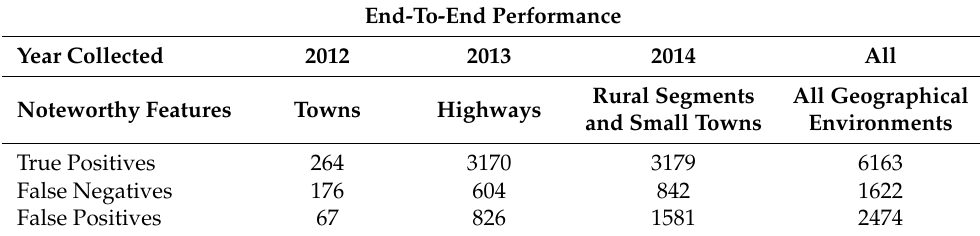
Table 4. A performance benchmark of the full system end-to-end. Raw images are fed into GPS- RetinaNet, which detects signs, predicts their class, and regresses their GPS offsets. Pairs of detections from consecutive frames predicted by GPS-RetinaNet are fed into the similarity network to predict a similarity score. These similarity scores are provided to the Hungarian algorithm to merge repeated detections of the same sign. These final sign predictions are compared to the annotations in the dataset to determine if they are true positives, false negatives, or false positives. The data are organized into three separate years in which it was gathered. Since each year represents a different set of driving environments, the results are shown separately. The 2012 data contain many towns, 2013 contain mostly highways, and 2014 contain a combination of towns are rural segments. The “All” section shows the combined results for all three years.